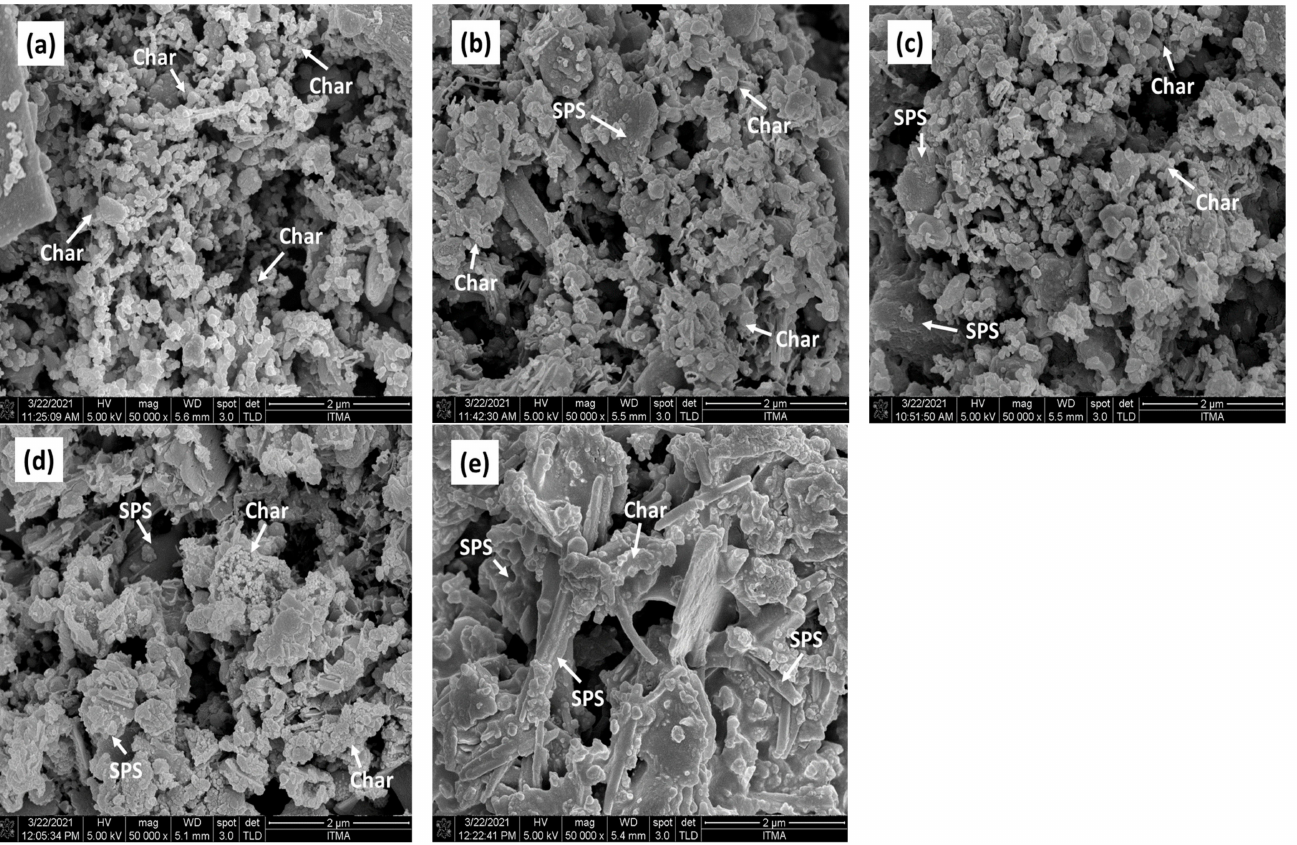
Figure 4. FESEM images of ( a ) C-100/SPS-0, ( b ) C-90/SPS-10, ( c ) C-80/SPS-20, ( d ) C-70/SPS-30, and ( e )